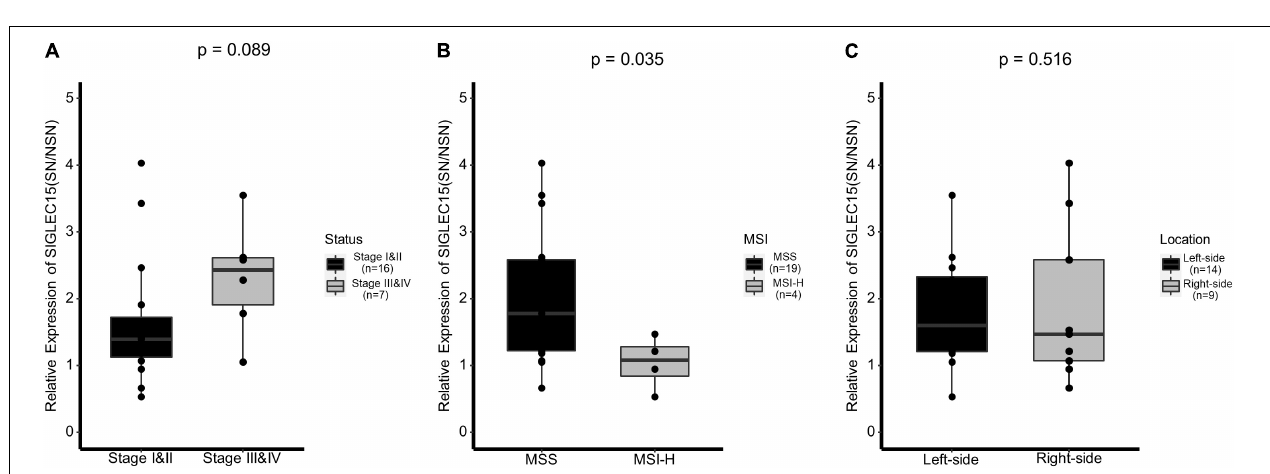
FIGURE 4 | The expression pattern of Siglec-15 protein in lymph node cell subsets. (A) The mean fluorescence intensity (MFI) of Siglec-15 in SN cell subsets determined by flow cytometry. * p < 0.05, ** p < 0.01, *** p < 0.001, with one-way ANOVA post-hoc Dunnett’s. (B) Flow cytometry analysis of Siglec-15 expression in respective lymph node subsets. * p < 0.05, ** p < 0.01, and *** p < 0.001, with paired t -test.